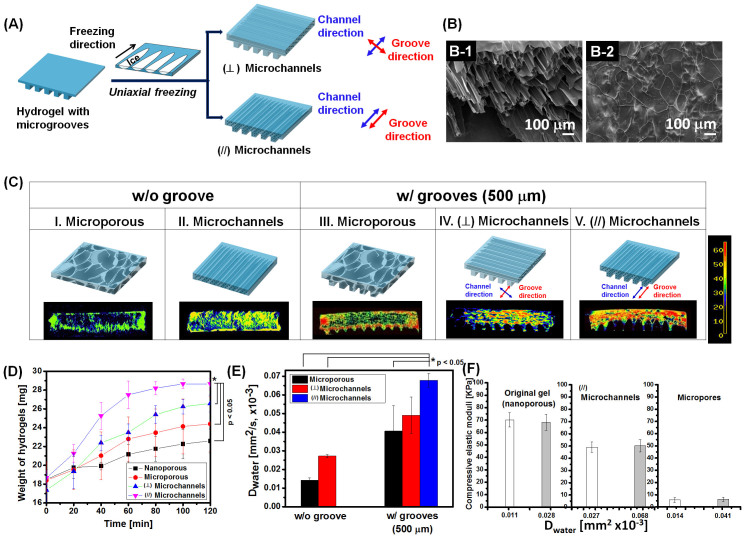
Tailoring the hydrogel permeability by introducing randomly oriented micropores or uniaxial microchannels.(A) Schematic describing the uniaxial freeze-drying process to introduce microchannels aligned perpendicular to microgrooves (upper process) or those aligned with microgrooves (lower process). (B) SEM images of the fractured surface of the microchanneled cryogel (B-1) and microporous cryogel (B-2). (C) MR images that display water distribution in rehydrated, microporous gel and microchanneled gels. The freeze-dried alginate cryogel was rehydrated with deionized water. “W/O groove” represents the hydrogels without microgrooves, and “w/grooves (500 μm)” represents the hydrogels with grooves of 500 μm-spacing. The “(⊥) microchannels” represents the hydrogel in which microchannels were aligned perpendicular to microgrooves on the surface, and the “(//) microchannels” represents the hydrogel in which microchannels were aligned in parallel with microgrooves on the surface. (D) The mass of hydrogels increased over time due to water diffusion into the hydrogel.  represents an original, nanoporous hydrogel which does not present either micropores or microchannels.  represents a microporous hydrogel prepared by the isotropic freezing process.  represents the (⊥) microchanneled and  represents the (//) microchanneled hydrogel (*p < 0.05). (E) Dwater of the microporous hydrogel (black bar), (⊥) microchanneled hydrogel (red bar), and (//) microchanneled hydrogel (blue bar) (*p < 0.05). (F) Effect of permeability on compressive elastic modulus of the hydrogels. For each condition, the left bar (i.e., opened one) represents the hydrogel W/O groove and the right bar (i.e., filled one) represents the hydrogel w/grooves (500 μm).